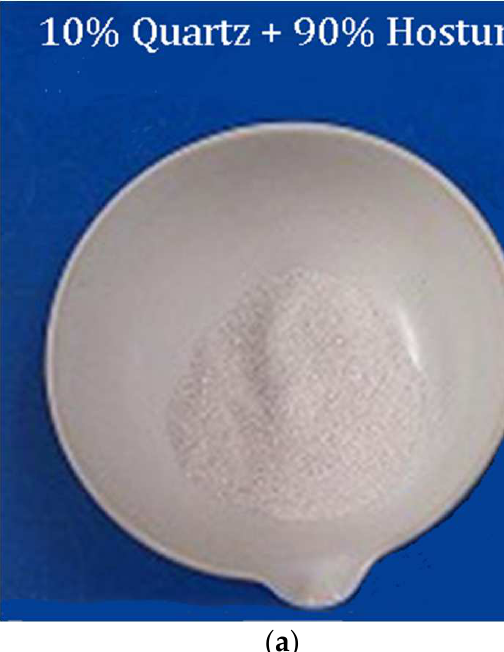
Table 1. Schedules of the various samples for micro-CT analysis for different densities.